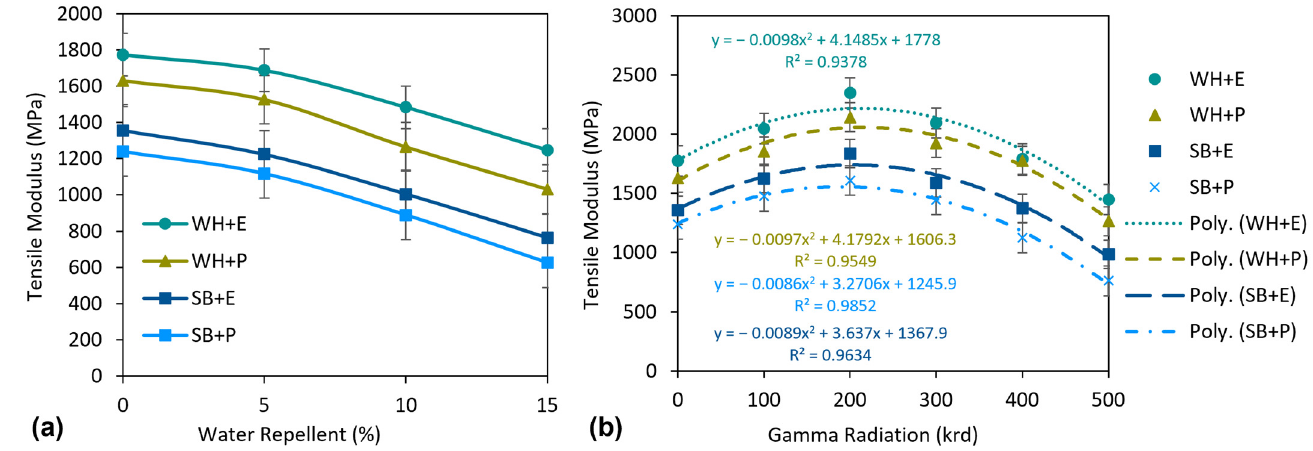
Figure 11. ( a ) Effect of water repellent treatment and ( b ) effect of gamma radiation on tensile modulus of the